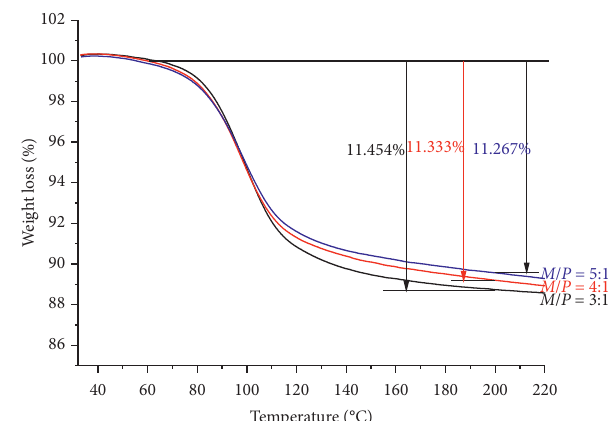
Figure 7: TG curves of MPC with different M / P mass ratios after curing for 3 d under air-curing